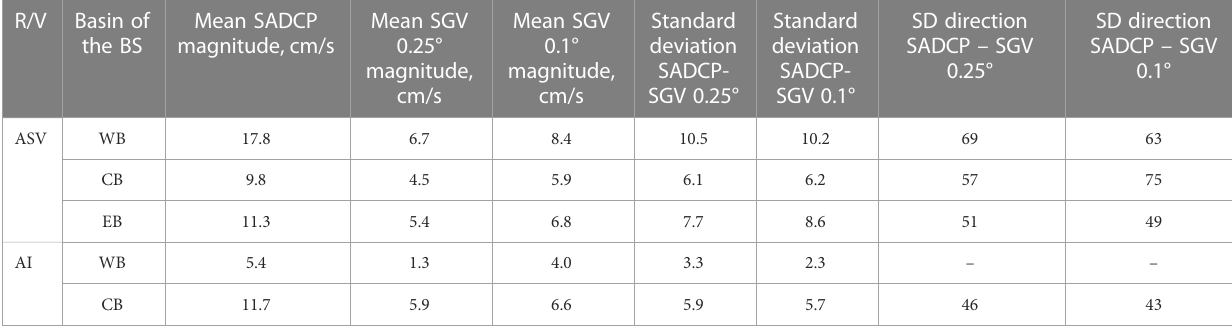
The fi rst column contains information about the vessels: R/V ASV (Akademik Sergey Vavilov, 76.8 kHz SADCP) and R/V AI (Akademik Ioffe, 38.4 kHz SADCP). Mean SADCP values were calculated based on the all available transects. Simultaneous sea surface geostrophic velocities (SGV) were interpolated to the points of SADCP measurements at the corresponding time; mean SGV values presented in the table were averaged based on these simultaneous velocities. Standard deviations of differences in magnitude between SGV and SADCP are presented for both altimetry datasets. Standard deviations of differences in the direction between SGV and SADCP are presented in the last two columns.